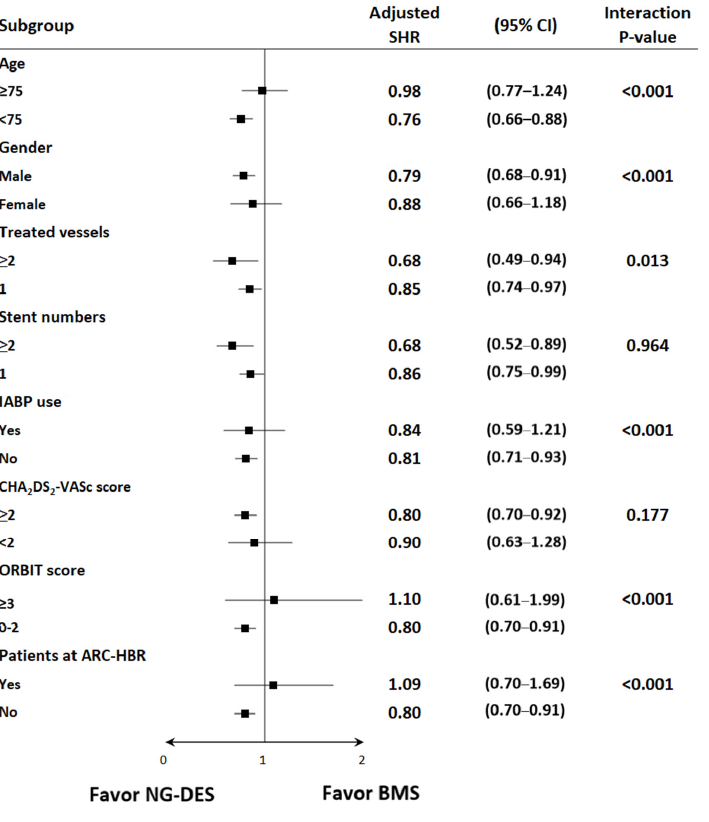
Figure 3. Subgroup analysis of the risk of HHF among patients with STEMI receiving NG-DESs (reference group) and BMSs. Adjusted SHR was adjusted for baseline covariates, including age, sex, year of index MI admission, comorbidities, prescribed medications, use of IABP during PCI, multivessel PCI, CHA 2 DS 2 -VASc scores, ORBIT scores, and various ARC criteria for HBR. Abbreviations are defined in the footnote of Table 1.